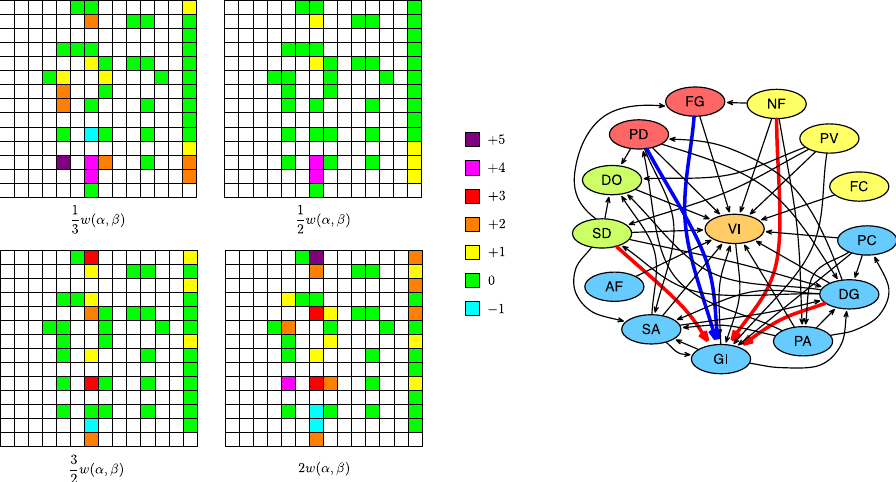
Fig. 5. (left) Color maps of the changes in the number of violent agents when the parameters w ð (cid:1);(cid:2) Þ are changed to 1/3, 1/2, 3/2, and 2 times their original values. In this ¯gure, the 14 (cid:5) 14 color maps are organized in the same way, the factor-to-factor matrix is in Table 2. (right) The three sensitive parameters for increasing parameter values (red) and two sensitive parameters for decreasing parameter values